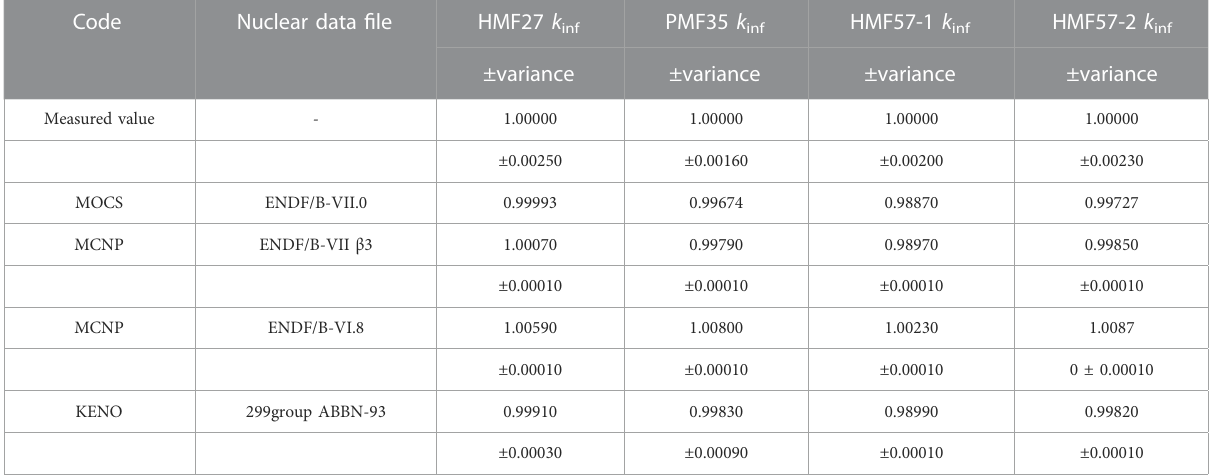
TABLE 3 The k inf results of lead-based critical experiments.